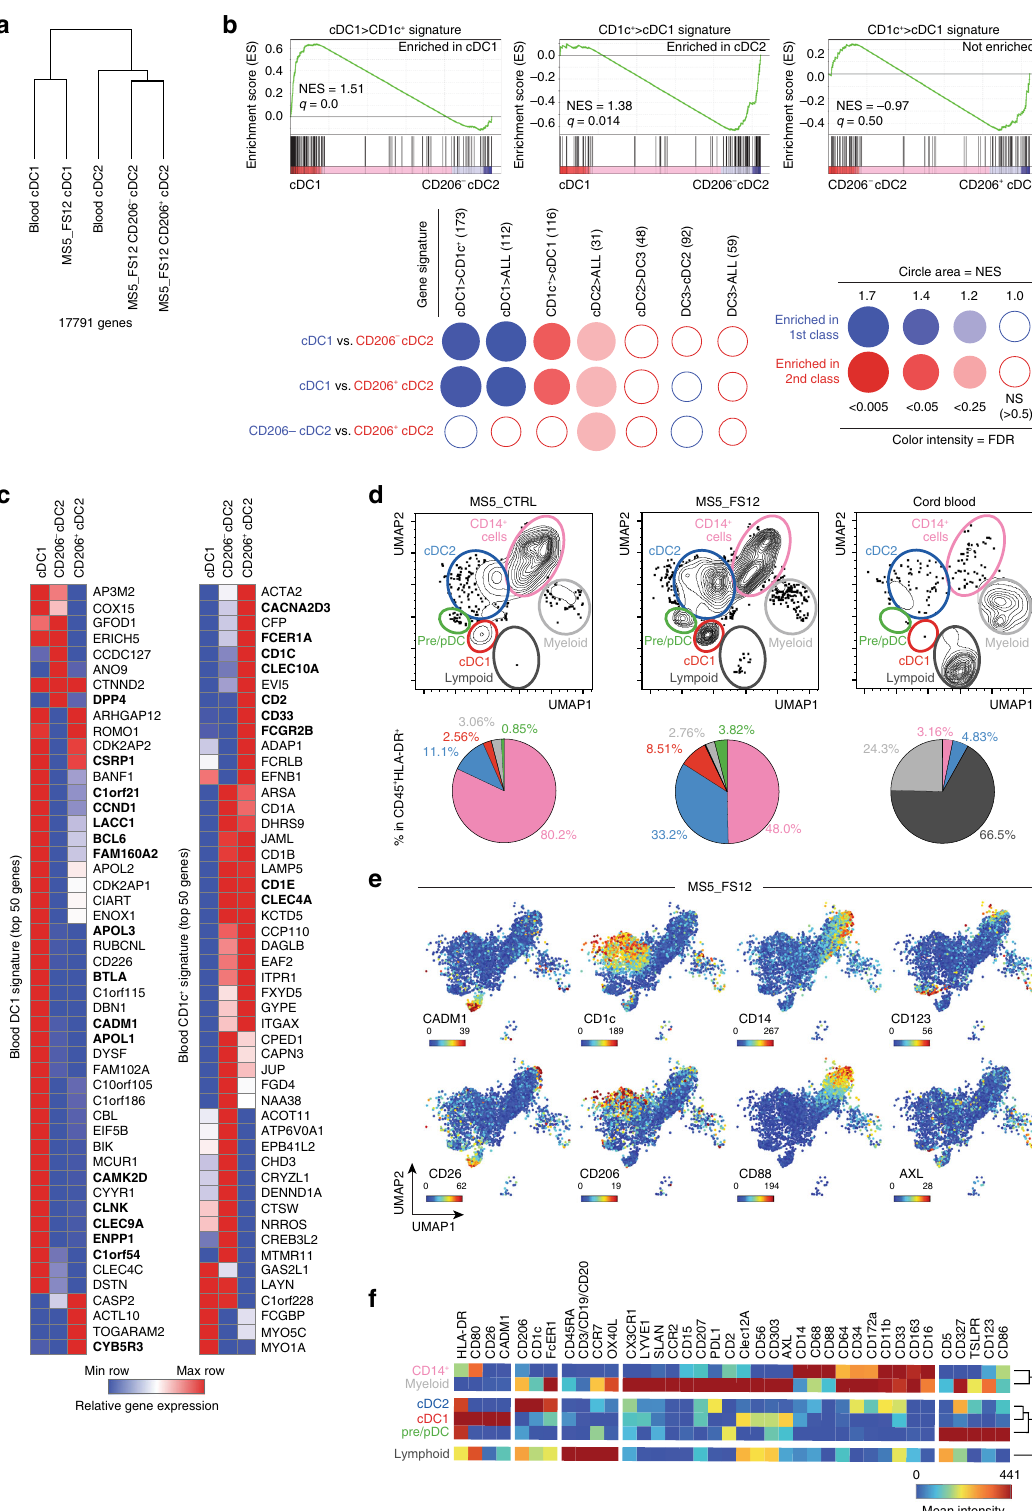
Clusters of cells embedded in Matrigel can be identi fi ed as early as day 12 by tissue histology (Fig. 5b). Flow cytometry analysis demonstrated that MS5_FS12 but not MS5_CTRL induced the expansion of human leukocytes within the Matrigel plugs (Fig. 5c). We then tested whether cell-to-cell interactions of eMSC with human progenitors play a role in this process. We